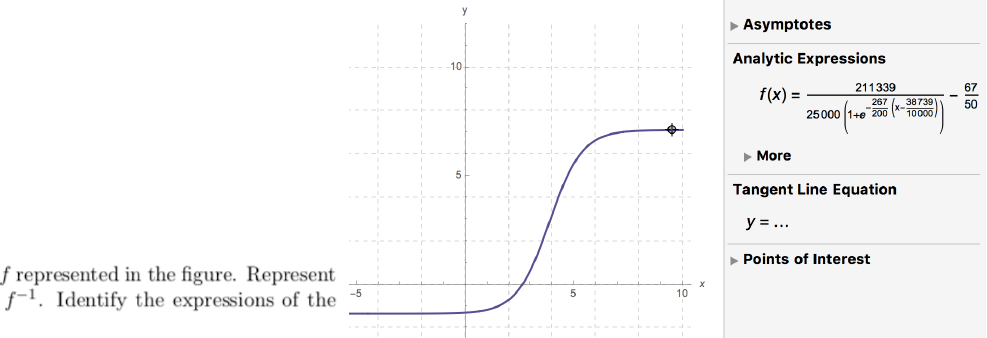
Figure 10. Example of a problem that can be projected and asked to be resolved by a student, in a remote or in a classroom learning environment, concerning the invertibility concept.